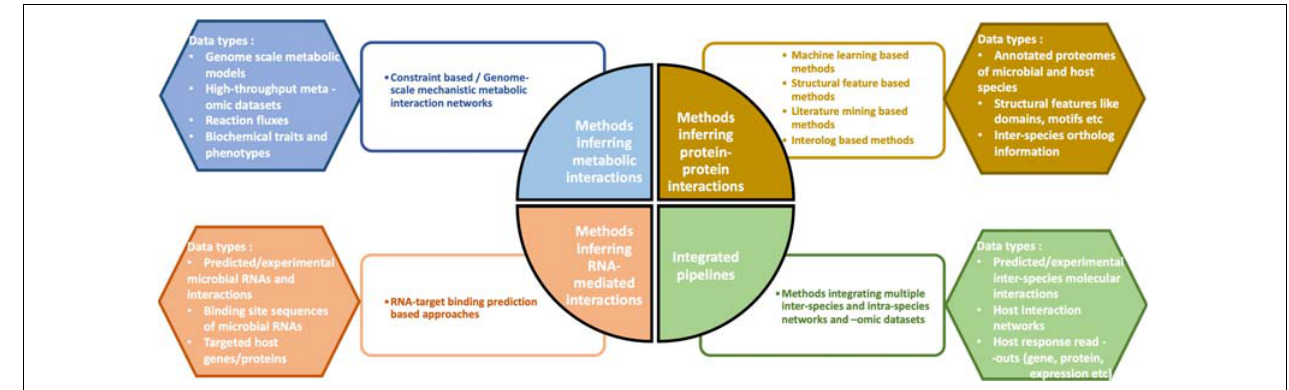
FIGURE 1 | Overview of the four different categories of computational methods which help infer the molecular mechanisms of microbe-host interactions. Some examples of data types corresponding to each of the four methods are